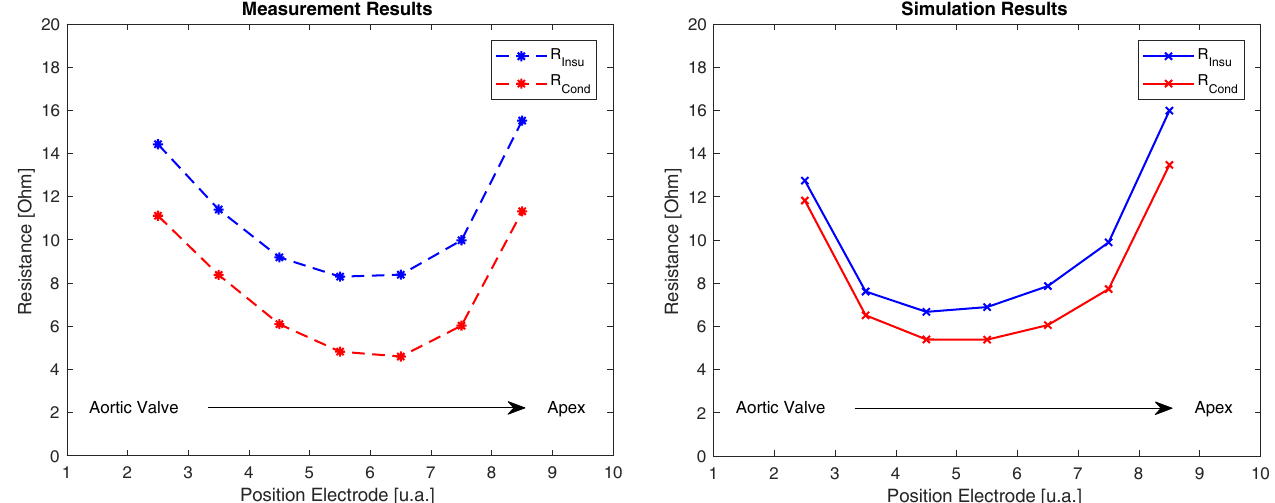
Fig.4: Left: Measured impedances in the conductive (red) and insulating silicone ventricle (blue) impedance; right: Simulated impedances in the conductive (red) and insulating ventricle